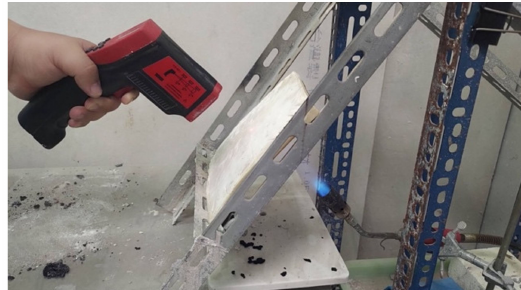
Figure 1. Layout of fire resistance test.